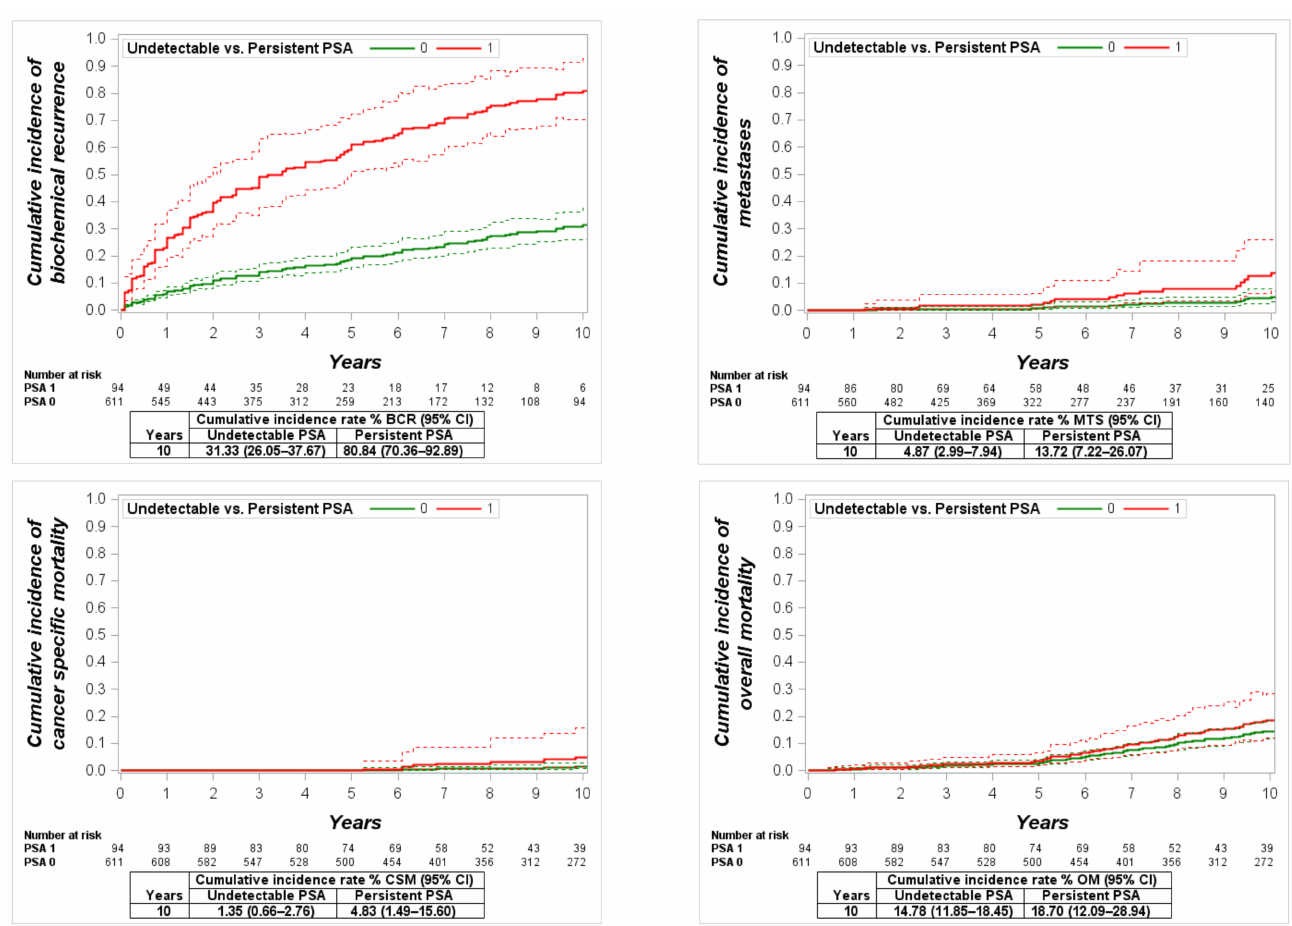
Figure 4. Cumulative incidence function for biochemical recurrence (BCR), metastases (MTS), cancer-specific mortal- ity (CSM) and overall mortality (OM) in intermediate-risk patients with undetectable vs. persistent prostate-specific antigen